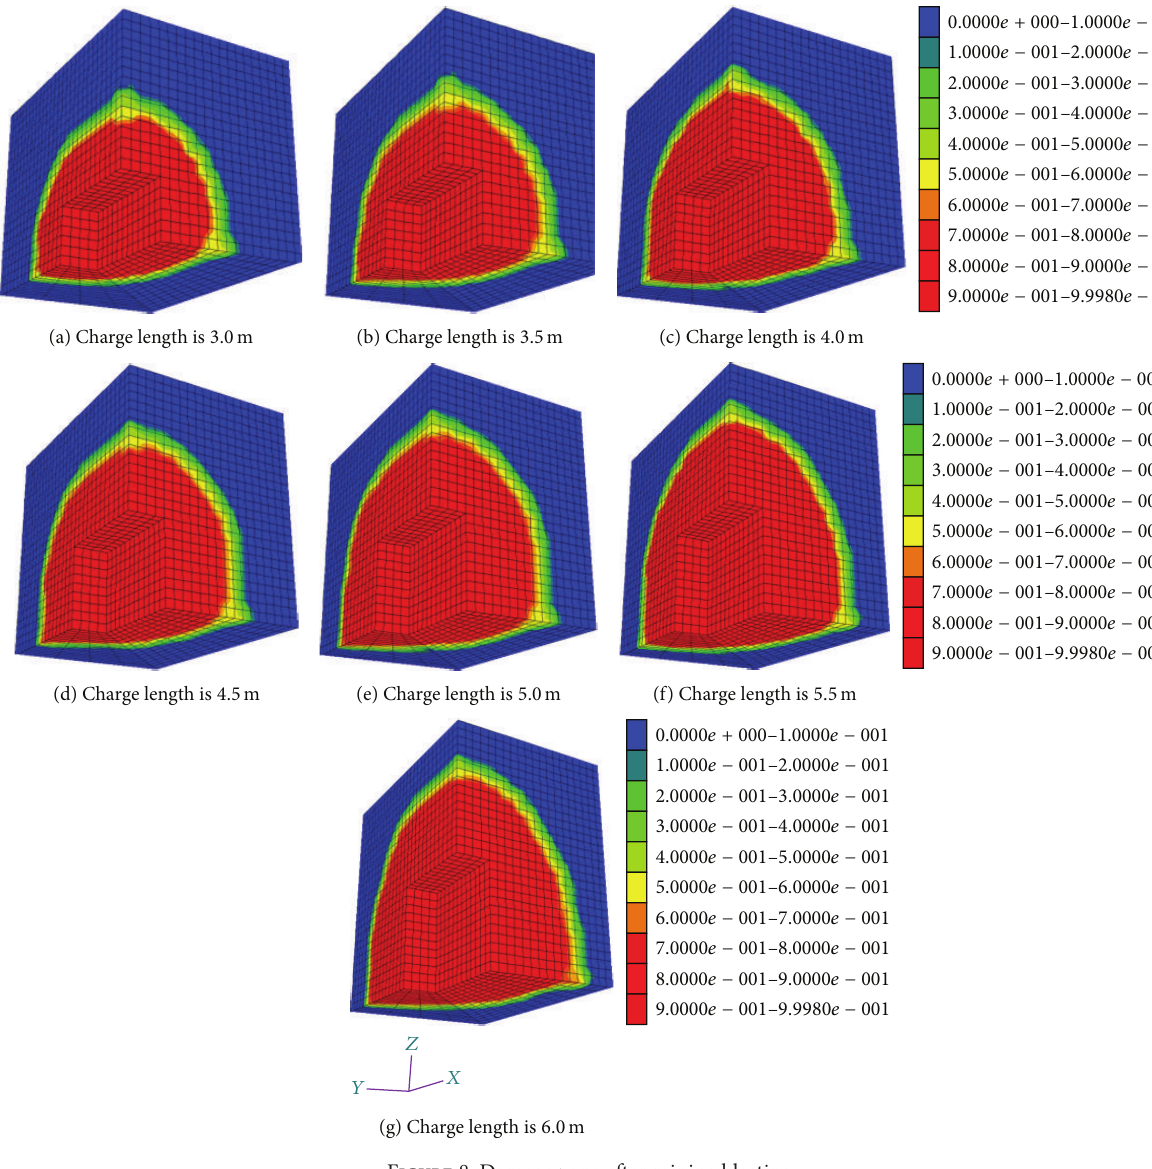
Figure 8: Damage zone after mining